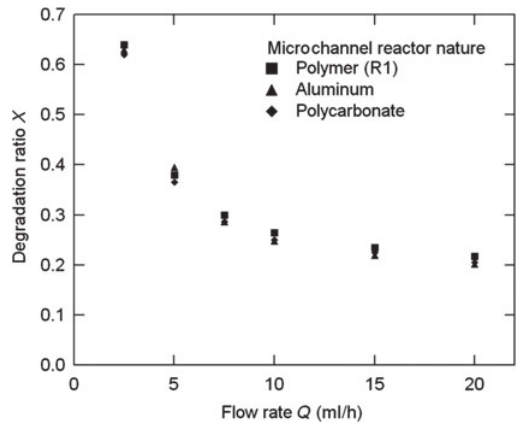
and polycarbonate microchannel reactors as a function of the flow rate. Geometrical characteristics of the reactors: w = 1 mm, h = 0.5 mm, and L = 70 mm. Experimental conditions: C I = 1.5 mW/cm 2